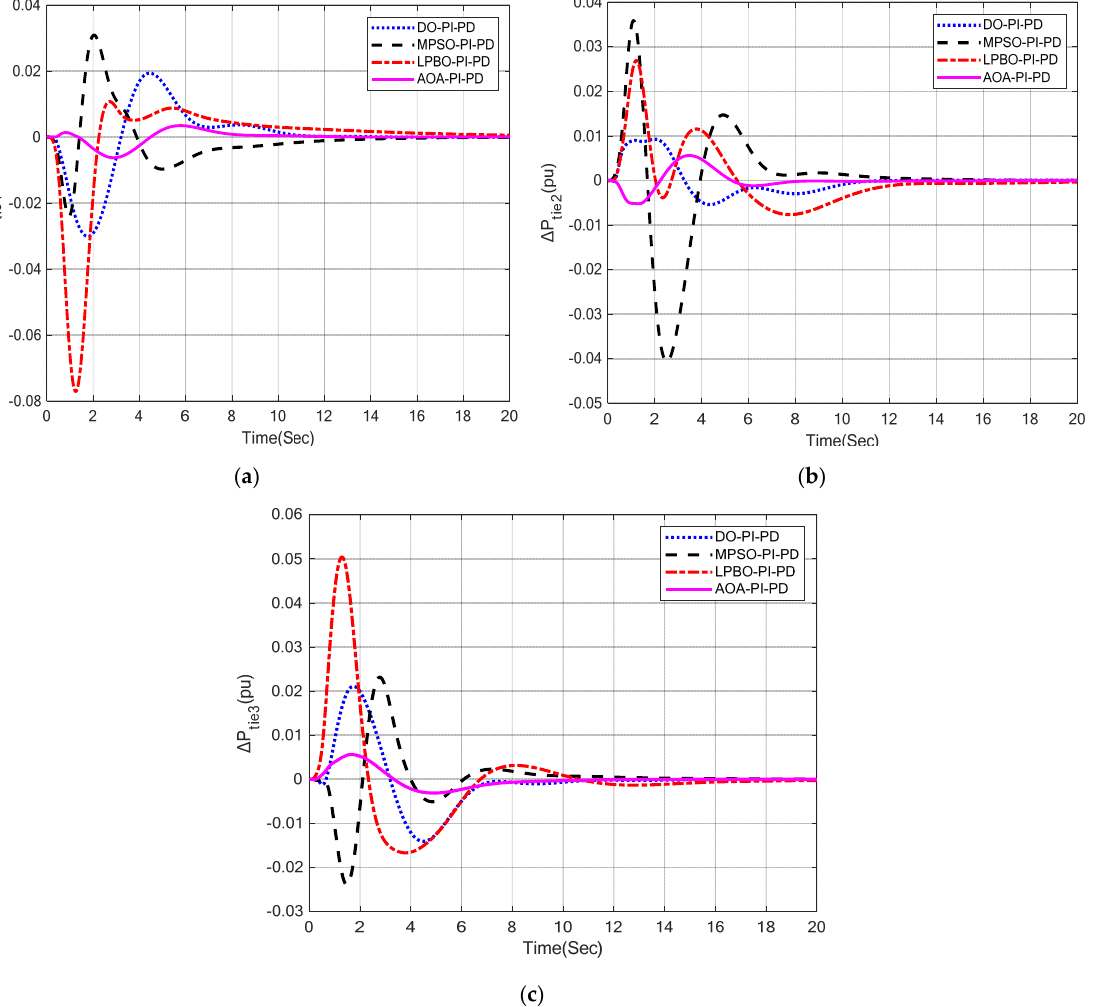
Figure 18. Tie-line power deviation responses in a three-area multi-source IPS with nonlinearities. ( a ) ∆ P tie1 ; ( b ) ∆ P tie2 ; ( c ) ∆ P tie3